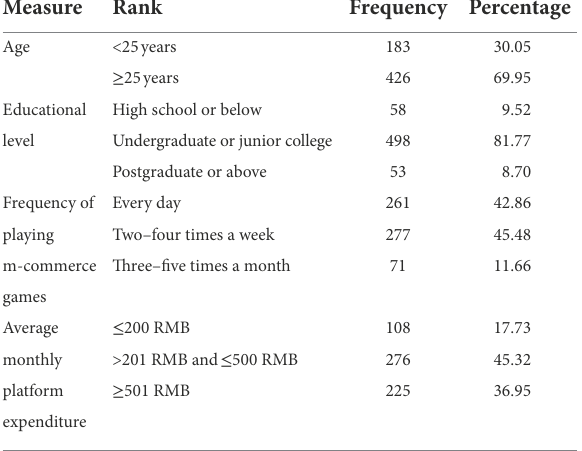
TABLE 2 Descriptive statistics of the participants.